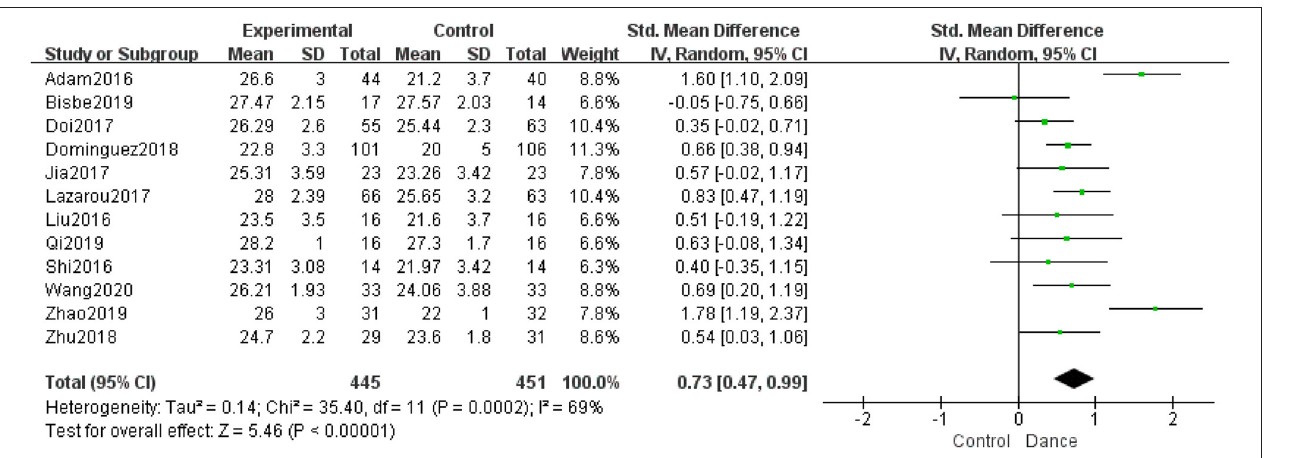
from 69% to 0% without influencing the overall pooled effect ( Figure 4